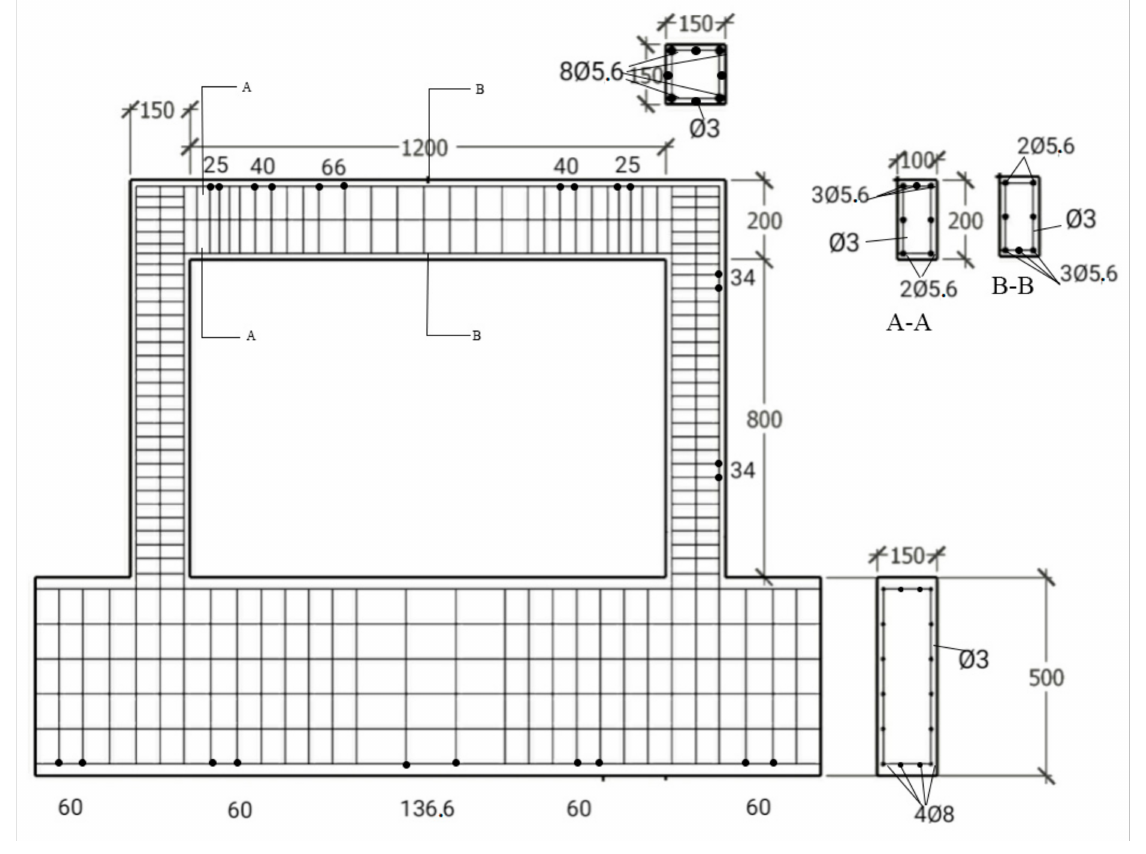
Figure 2. Model of building type. Table 3. Properties of materials